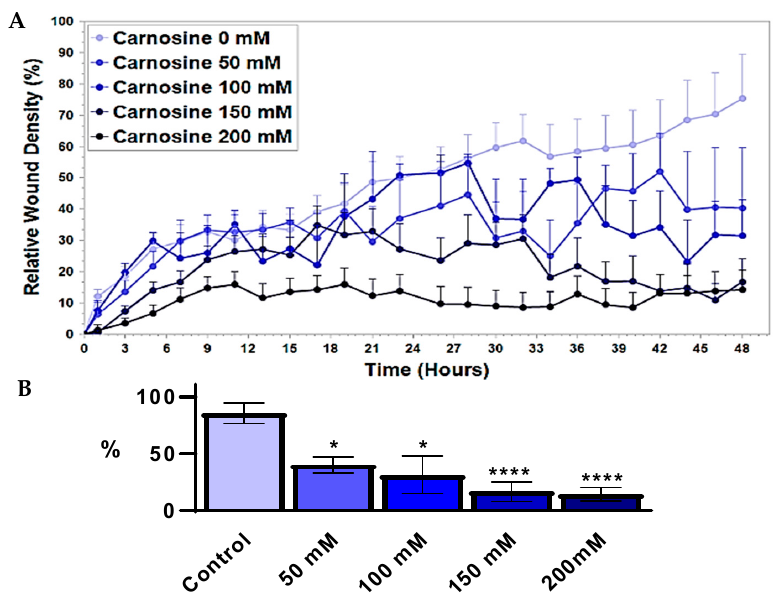
Figure 11. Effect of carnosine concentration on U87 cells’ wound healing by invasion over 48 h. ( A ) The same criteria as migration were applied to quantitatively address the effect of carnosine. ( B ) The statistical analysis shows a significant effect caused by carnosine (50 mM) at a cell density of 10 3